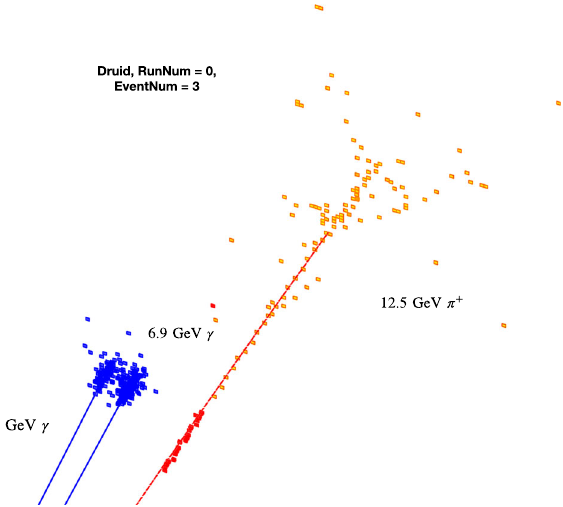
Fig. 1 The event display of two photons and one charged pion, gen- erated from a hadronic τ decay. The blue hits around the blue solid lines are the ECAL hits of a 3.8 GeV photon shower and a 6.9 GeV photon shower. The red hits around the red dashed line are the ECAL hits belonging to a 12.5 GeV π + shower, while the orange hits are the HCAL hits of the same π + shower. The size of these cells is 1 × 1 cm